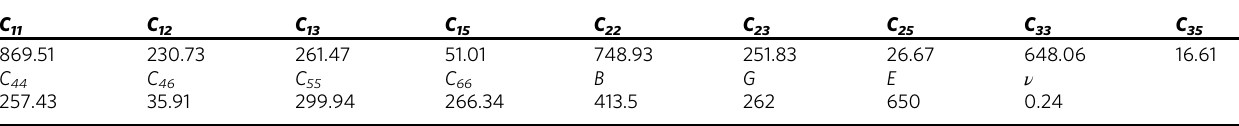
Table 3 Calculated elastic properties of ReN